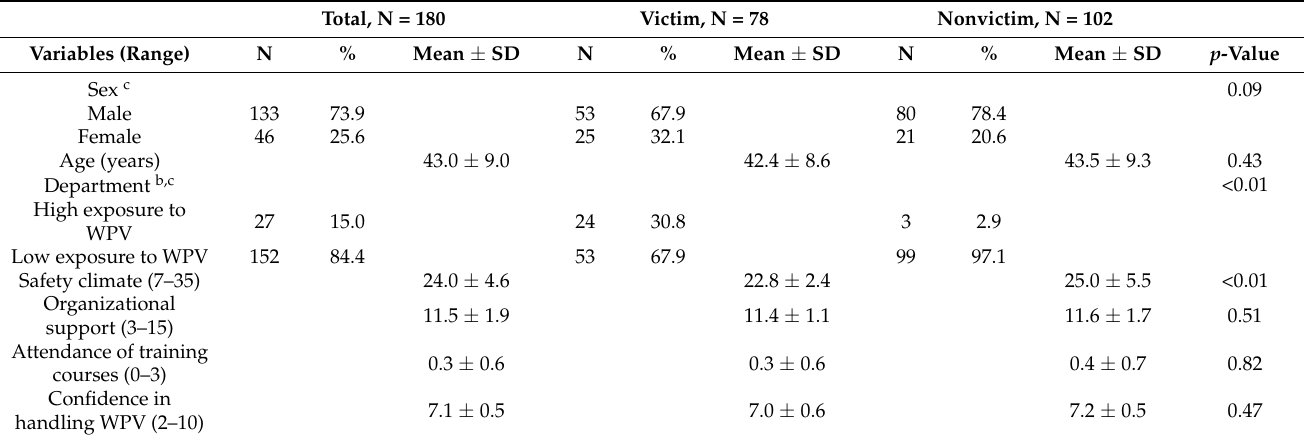
Table 1. Descriptive information of respondents’ demographics, experience of WPV a in the preceding 3 months, confidence in handling WPV, and associated